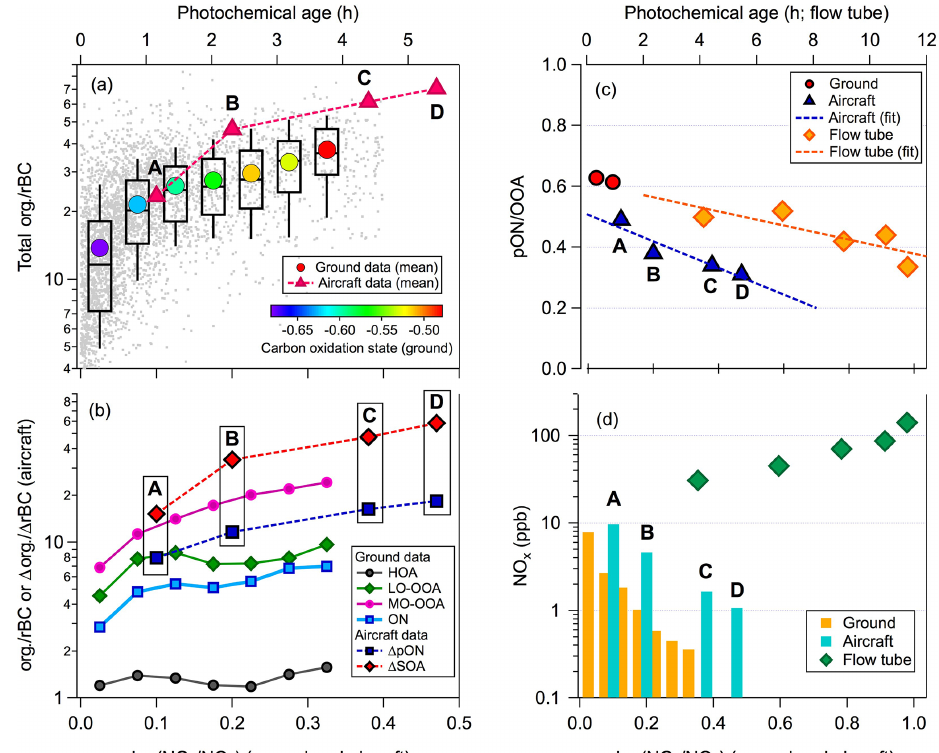
Figure 3. Comparison between ground-based, aircraft and flow tube data as a function of − log(NO x / NO y ) or photochemical age (PCA): (a) rBC normalized mass loadings of total organic, (b) rBC-normalized mass loadings (mean) of HOA, LO-OOA, MO-OOA and pON, (c) pON / OOA ratios (i.e. OOA is LO-OOA observed from the ground site, OOA is total SOA in the plume observed from the aircraft measurement, and OOA is total SOA produced in the flow tube experiments) and (d) NO x mixing ratio. The pON data presented here are upper limit based on the assumption of R ON = 5 and MW ON = 300gmol − 1 . The colour scale of solid circles in (a) represents the average carbon oxidation state of OA materials, assuming that ambient daytime OH radical concentration was ∼ 7 × 10 6 moleculescm − 3 (Liggio et al., 2016) and the major NO x loss product was HNO 3 . The PCA of air masses (i.e. PCA =− ln ( [ NO x ] / [ NO y ] )/k rxn [OH]) was estimated using a rate constant between OH radical and NO x for HNO 3 formation ( k rxn ) of 7 . 9 × 10 − 12 cm 3 molecules − 1 s − 1 (Brown et al., 1999; Cappa et al., 2012). Only the first two points of ground data were included in (c) as a reference for the pON / OOA ratio of the fresh SOA. Letters A to D in all the panels refer to the measurements at the four screens indicated in Fig.